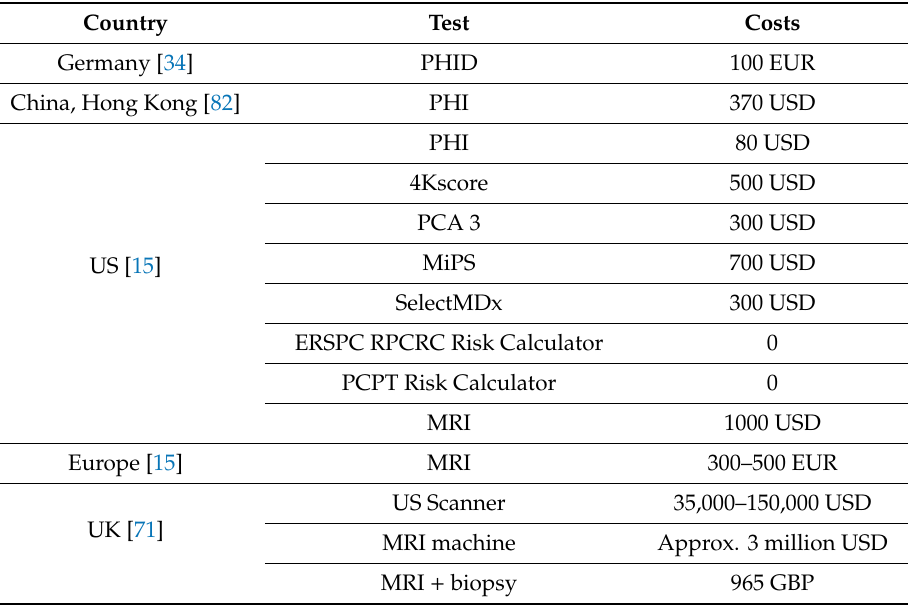
Table 3. Economic aspects of di ff erent tests around the